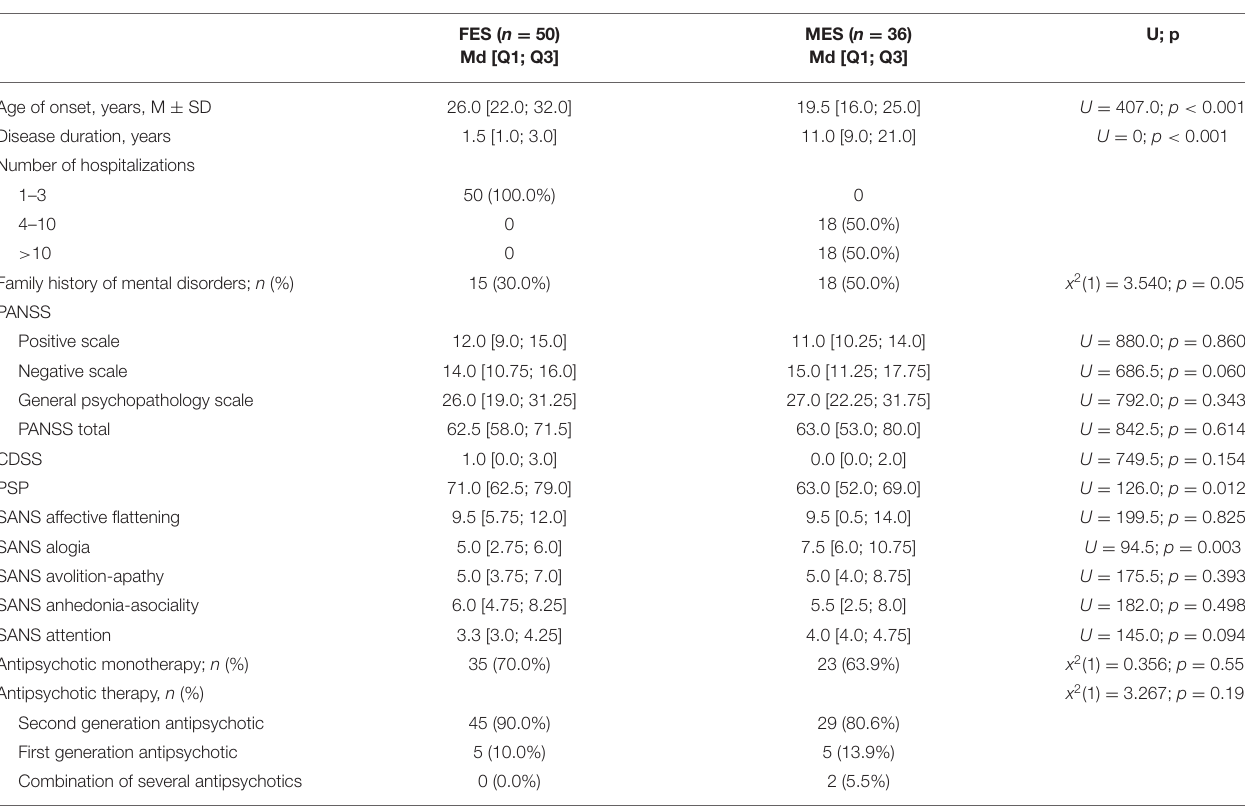
TABLE 2 | Clinical